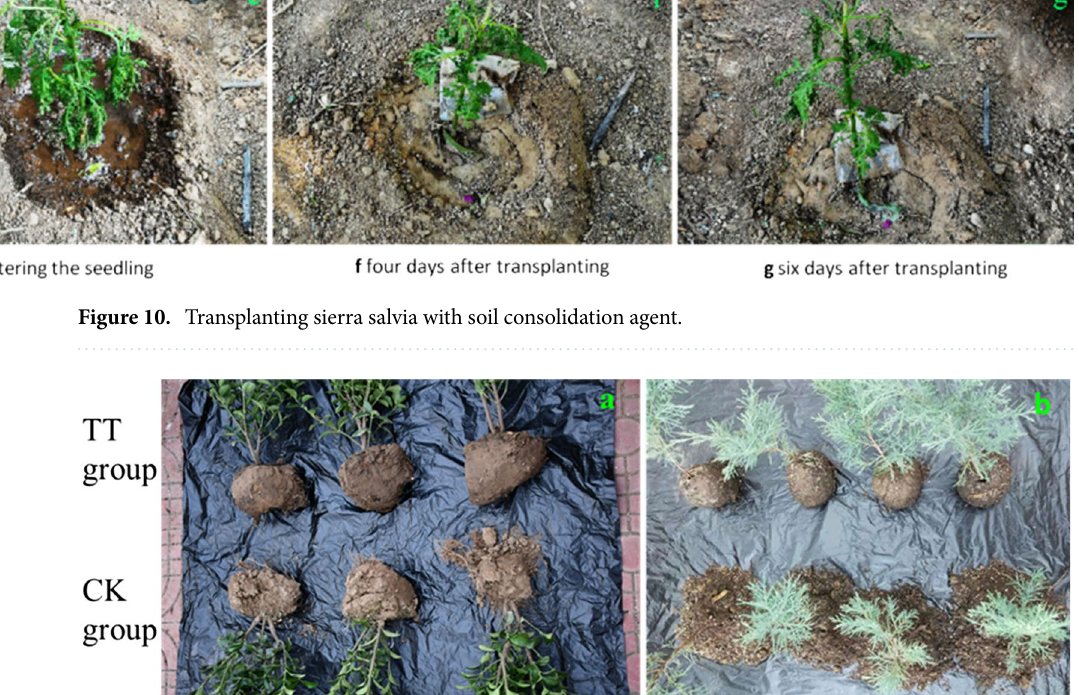
Figure 11. Application of ternary blend adhesive to Japanese Spindle ( Euonymus japonicus ) ( a ) and Juniperus sabina ‘Tamaricifolia’ ( b